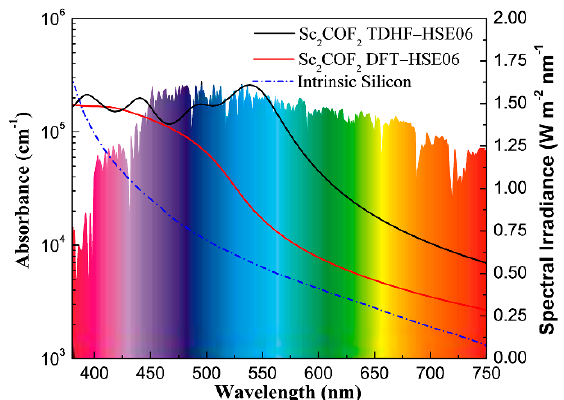
Figure 7. Calculated optical absorption coefficients of Sc 2 CF 2 compared with the experimental spectrum of intrinsic silicon. The colorful background is the reference solar spectral irradiance [45].